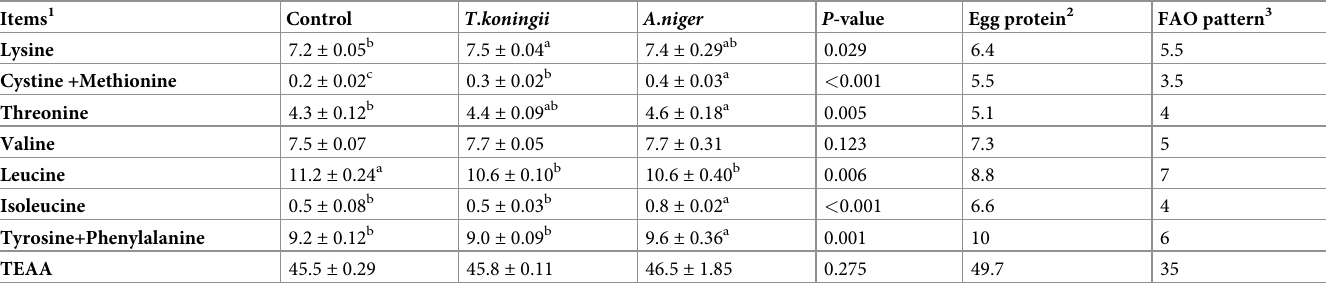
Table 5. Essential amino acids composition of fermentation